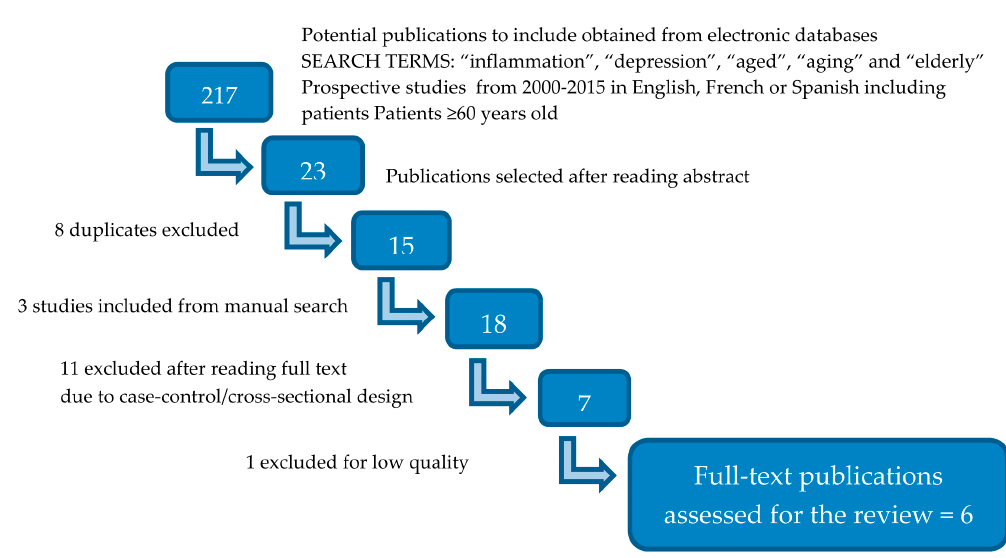
Figure 1. PRISMA (Preferred Reporting Items for Systematic Reviews and Meta-Analyses) flowchart of publications selection procedure.